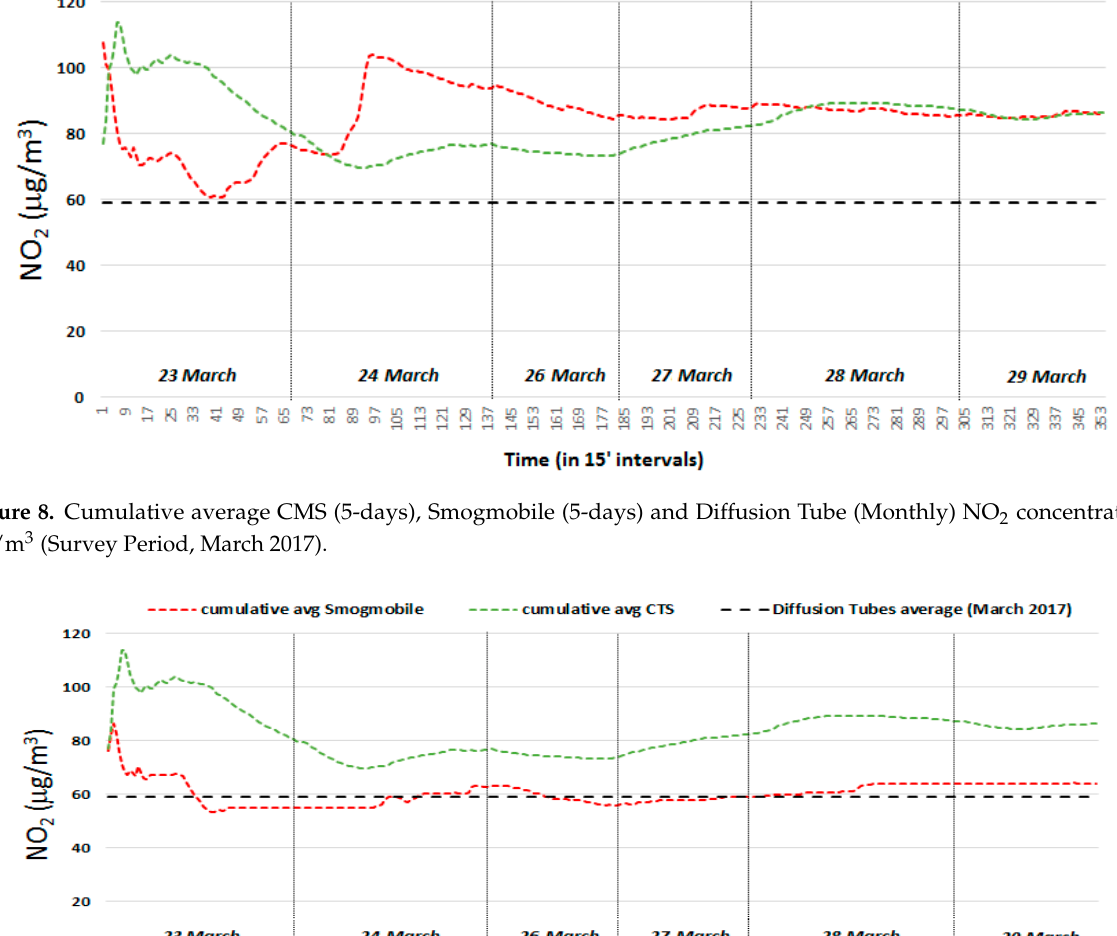
Figure 8. Cumulative average CMS (5-days), Smogmobile (5-days) and Diffusion Tube (Monthly) NO 2 concentrations, µg/m 3 (Survey Period, March 2017).